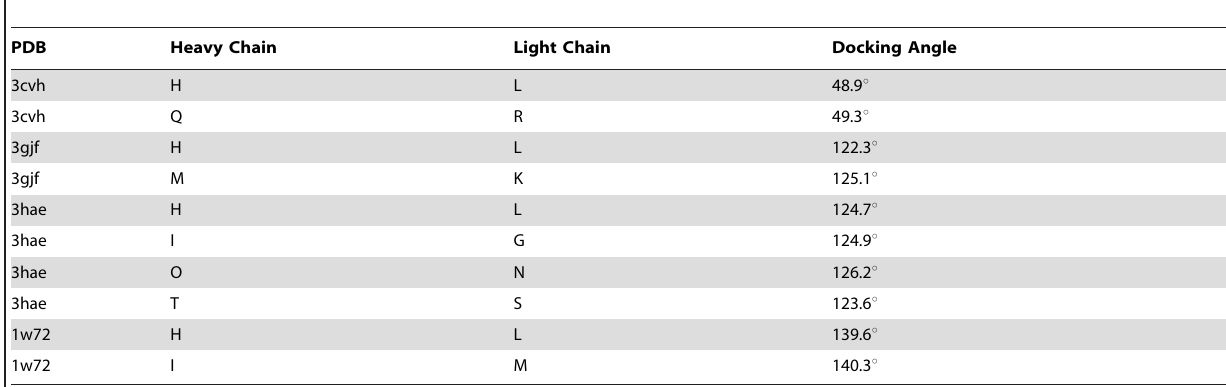
Table 1. The docking angle for each TCR-like antibody/MHC complex.